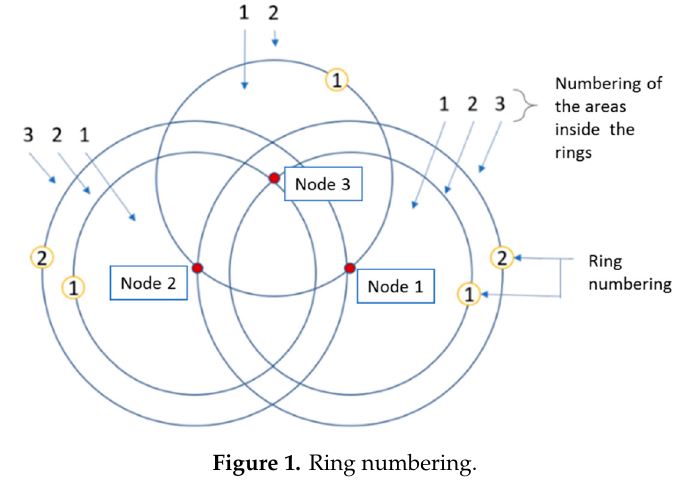
Figure 1. Ring numbering .